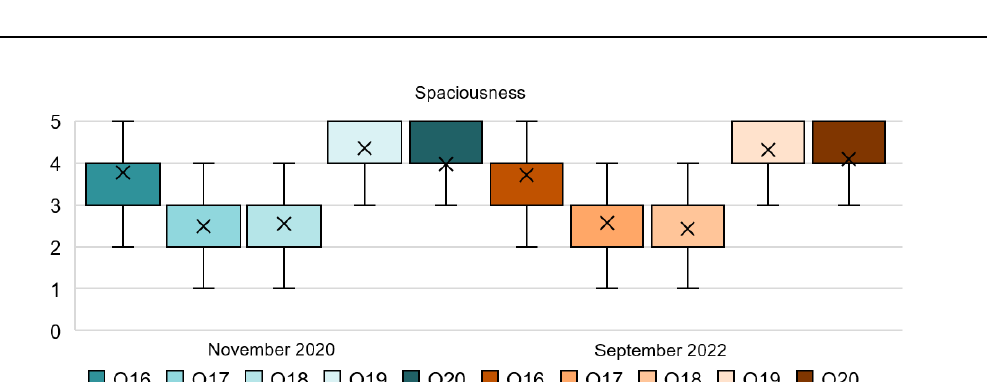
Figure 7. Interval data graph of the Spaciousness dimension.